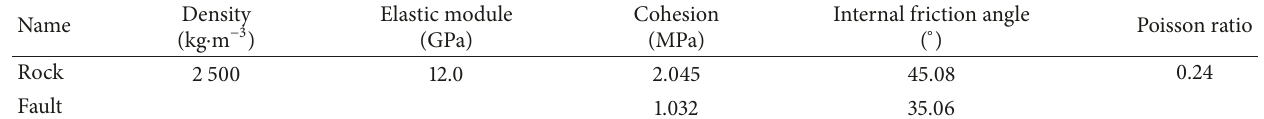
Table 2: Mechanical parameters of rocks.